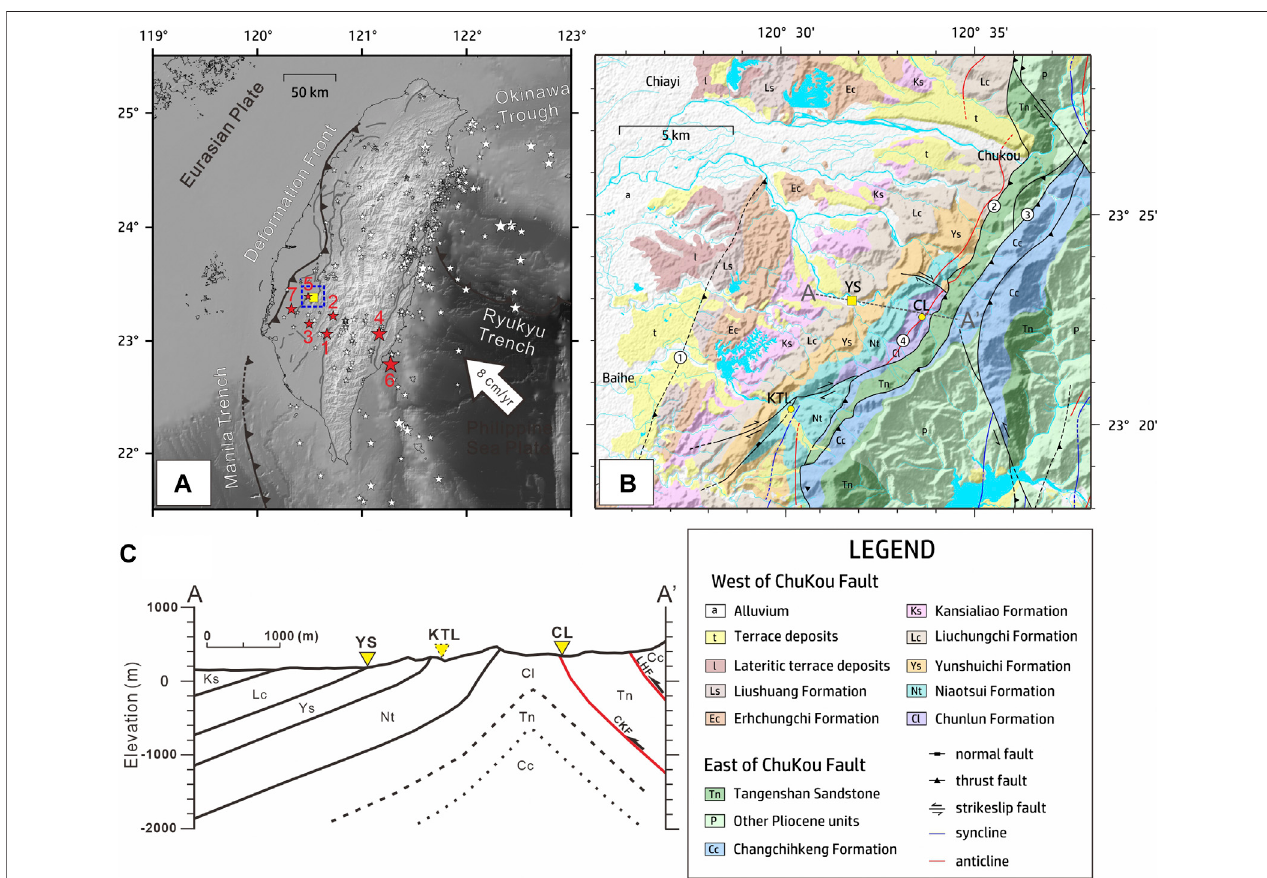
FIGURE1|(A) Thesimpli fi edsketchoftheregionalmapandprincipaltectonicstructuresshowsthePhilippineSeaPlate(PSP)ismovingnorthwesttowardTaiwan at a rate of approximately 8 cm/yr (Yu et al., 1997). (B) The geological and topographic map of southwestern Taiwan and the relative position of the study area and is marked by the blue dashed rectangle in Figure 1A . (C) A schematic diagram showing a cross-section along the geological transect (A – A ′ in Figure 1B ) [modi fi ed from Hsu and Wey, 1983). The yellow square represents the location of the YS station. The red star symbols represent the related earthquake epicenter with local intensity ≥ 2 around YS station and are labeled and listed in Table 1 . Structure lines denote the 1) Muchiliao Fault (MCLF), 2) Chukou Fault (CKF), 3) Lunhou Fault (LHF), and 4) Chunlun Anticline.